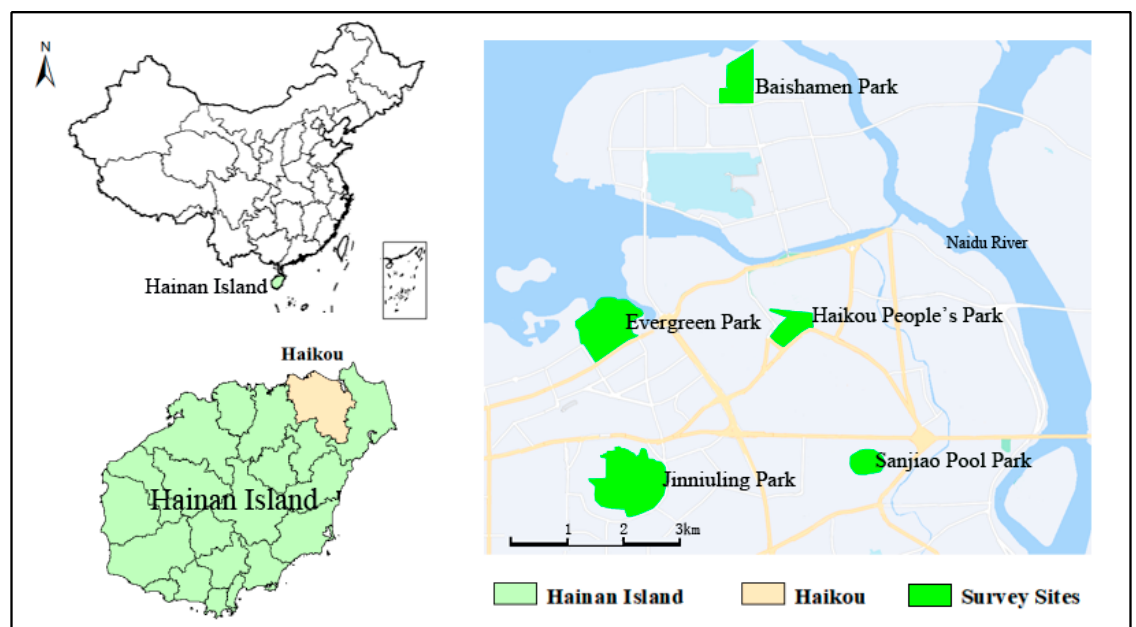
Figure 2. Location of the study area.